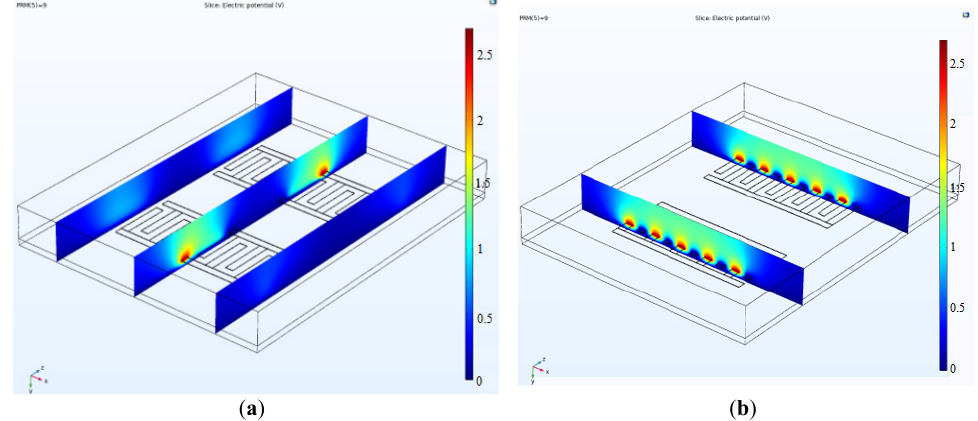
Figure 5. ( a , b ) The electrical potential counters of the sensor for a bias voltage of 2.7 Volts. The substrate is grounded.